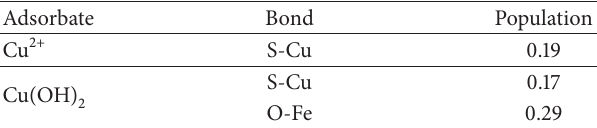
Table 2: Mulliken population of bond formationon Cu 2+ and Cu(OH) 2 adsorbed